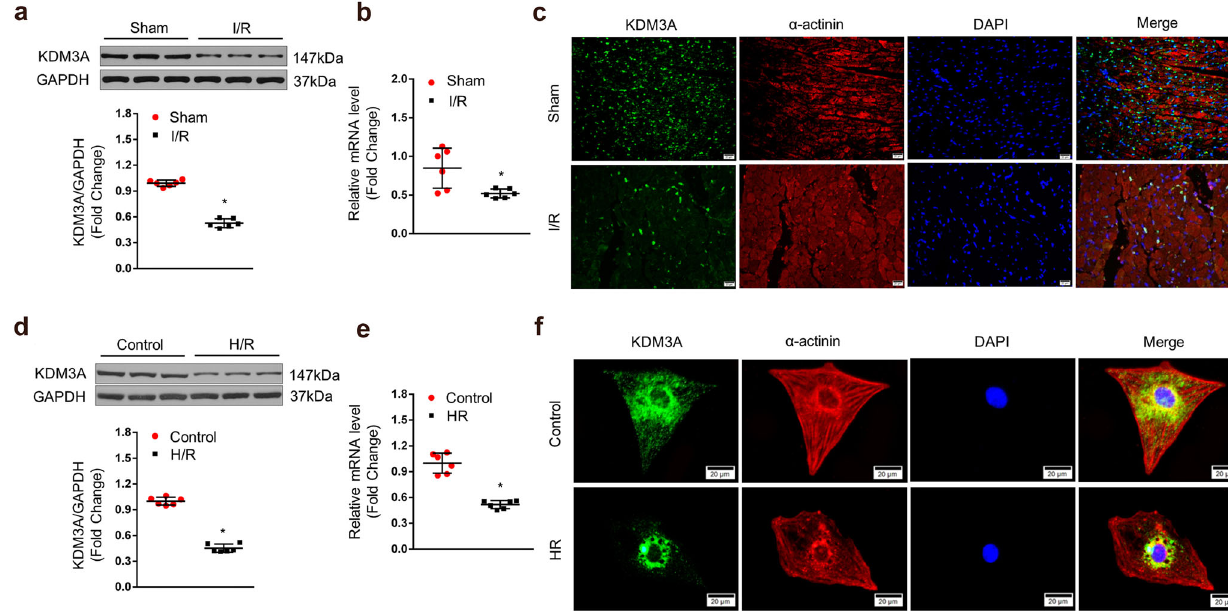
Fig. 1 KDM3A expression was downregulated after MIRI. a , b Levels of KDM3A protein (detected by Western blot assay) ( a top panels are representative blots; bottom bar graphs show quantitative results) and mRNA (detected by qRT-PCR) ( b ) in rat heart at post I/R injury or a sham- operation ( n = 6, * P < 0.05 vs. sham). c Representative dual immuno fl uorescence staining of KDM3A (green) and α -actinin (red) in heart sections with or without I/R injury ( n = 4). The nuclei were stained with DAPI (blue). The upper panel shows heart sections from sham-operated animals; the lower panel shows heart sections from the I/R group. Scale bar = 20 μ m. d , e Levels of KDM3A protein ( d top panels are representative blots; bottom bar graphs display quantitative results) and mRNA ( e ) (n = 6, * P < 0.05 vs. control) in cultured NRCMs in the absence or presence of H/R injury. f Double immuno fl uorescence images of KDM3A (green) and α -actinin (red) in NRCMs treated with H/R or normoxic controls ( n = 4). The top panels and bottom panels display cardiomyocytes subjected to normoxic control and H/R injury, respectively. Scale bar = 20 μ (Fig. 4e) compared to KDM3A + / + rats after reperfusion. The impacts of KDM3A de fi ciency on apoptosis, mitochondrial structure, ROS and in fl ammation on MIRI were also examined.